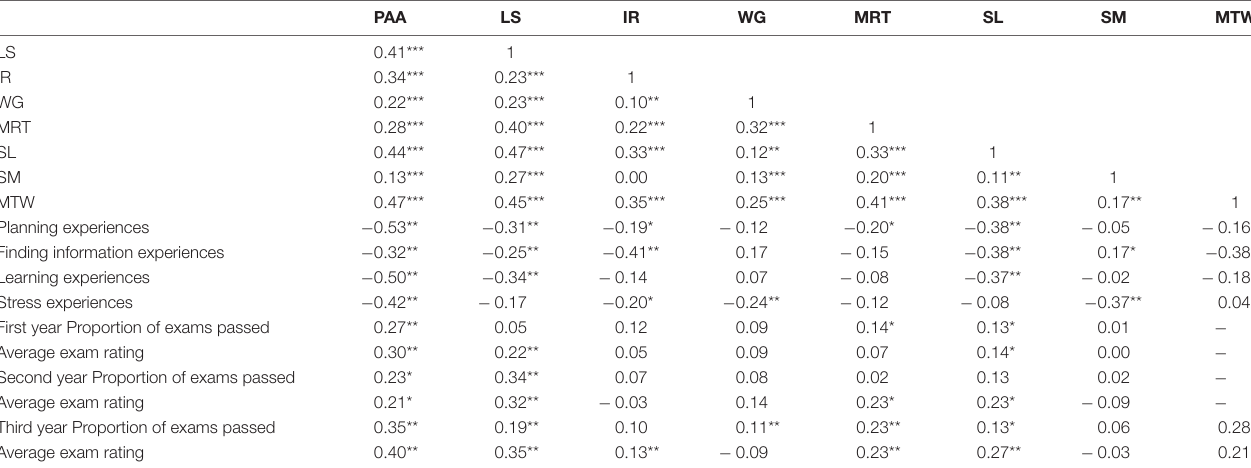
TABLE 3 | Pearson correlations among Academic Self-efficacy factors and indicators of students’ academic experiences and performance. PAA